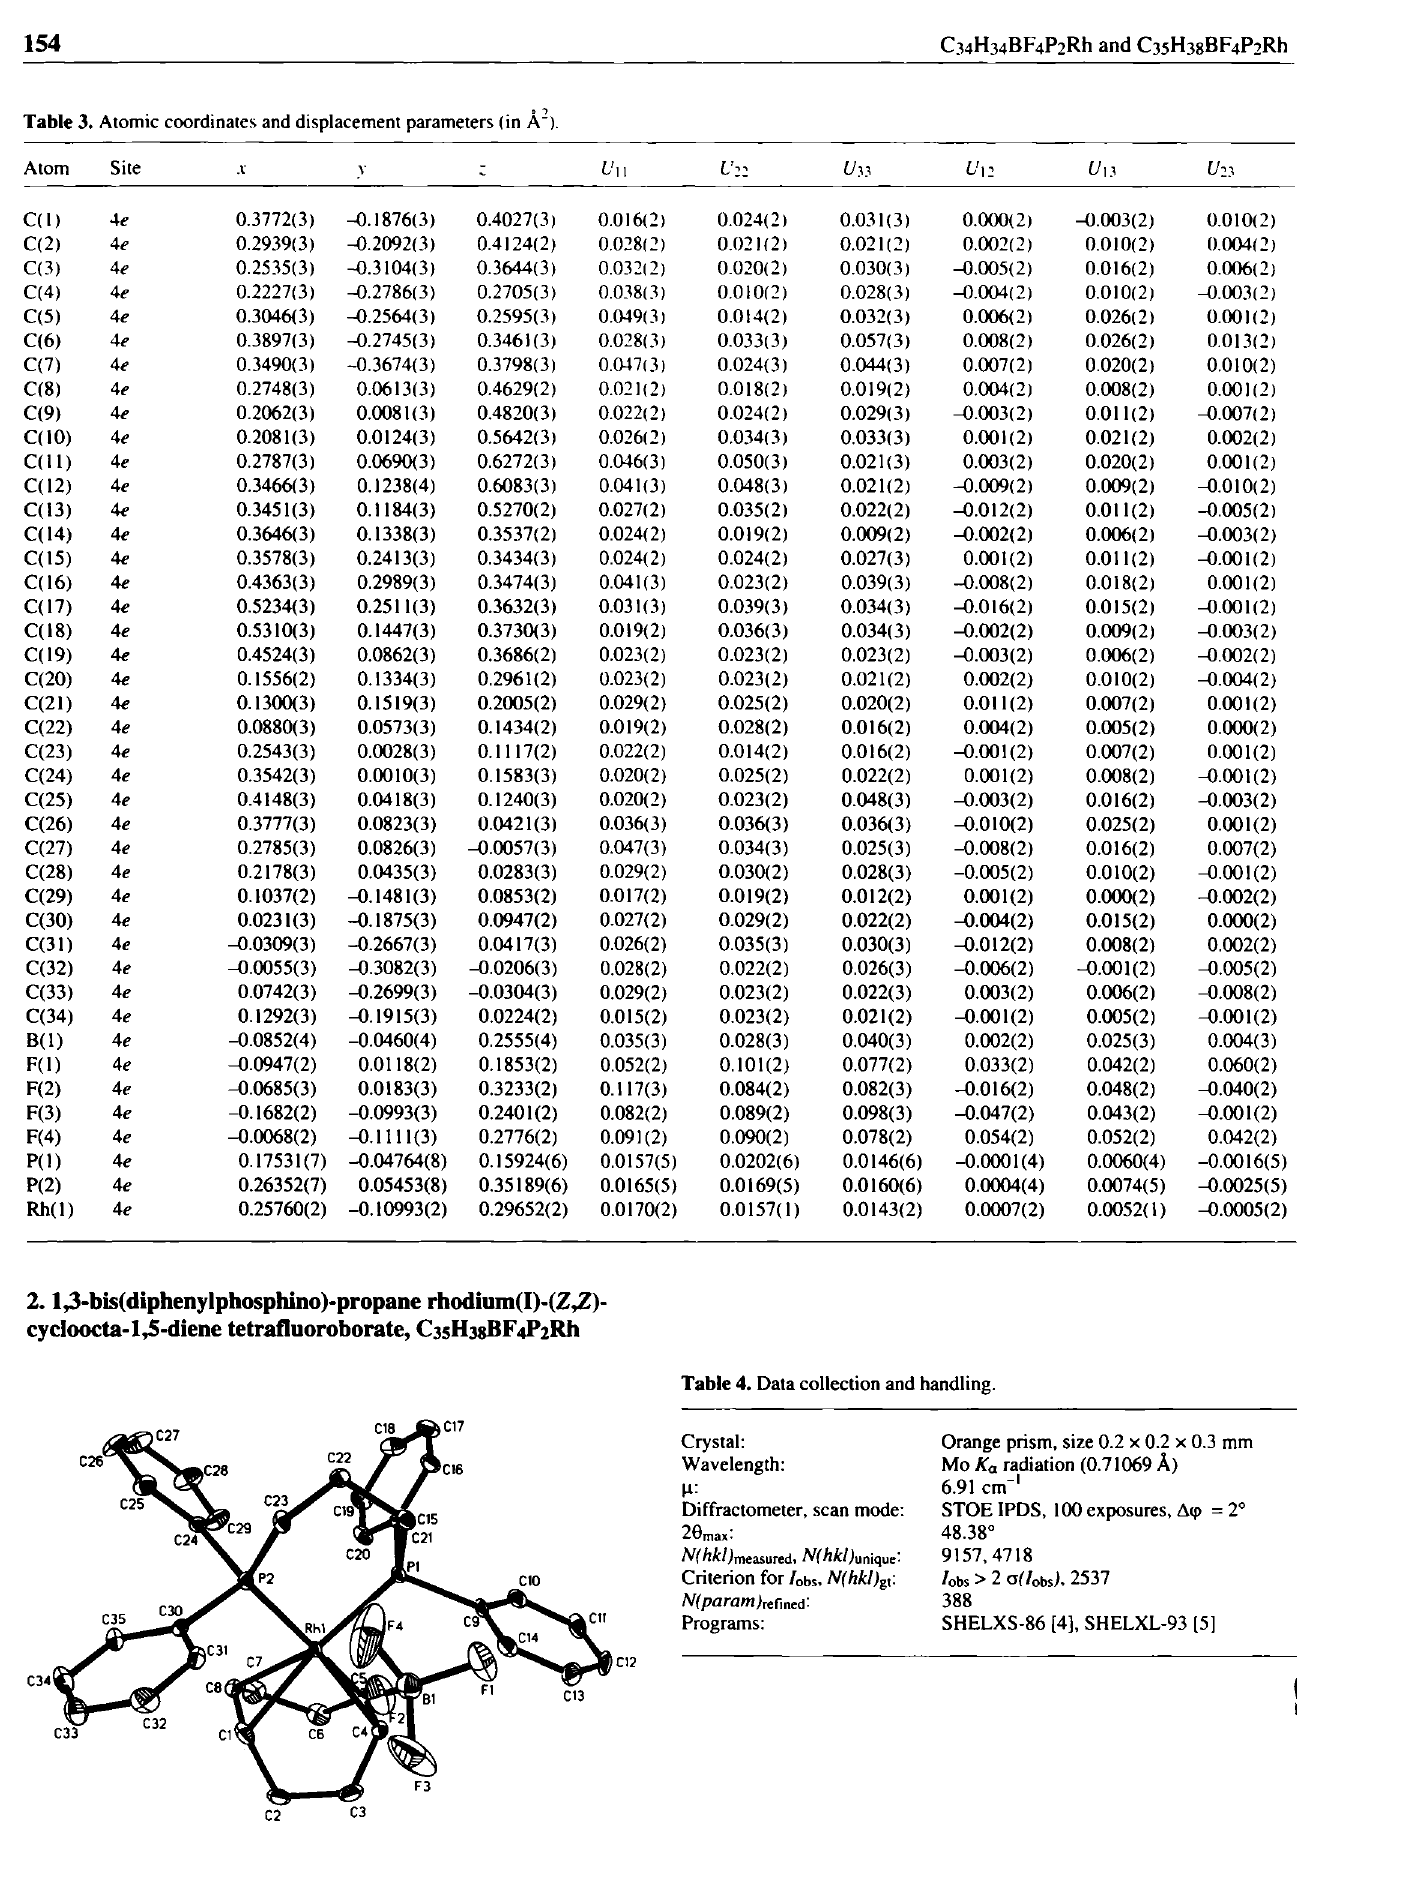
Table 4. Data collection and